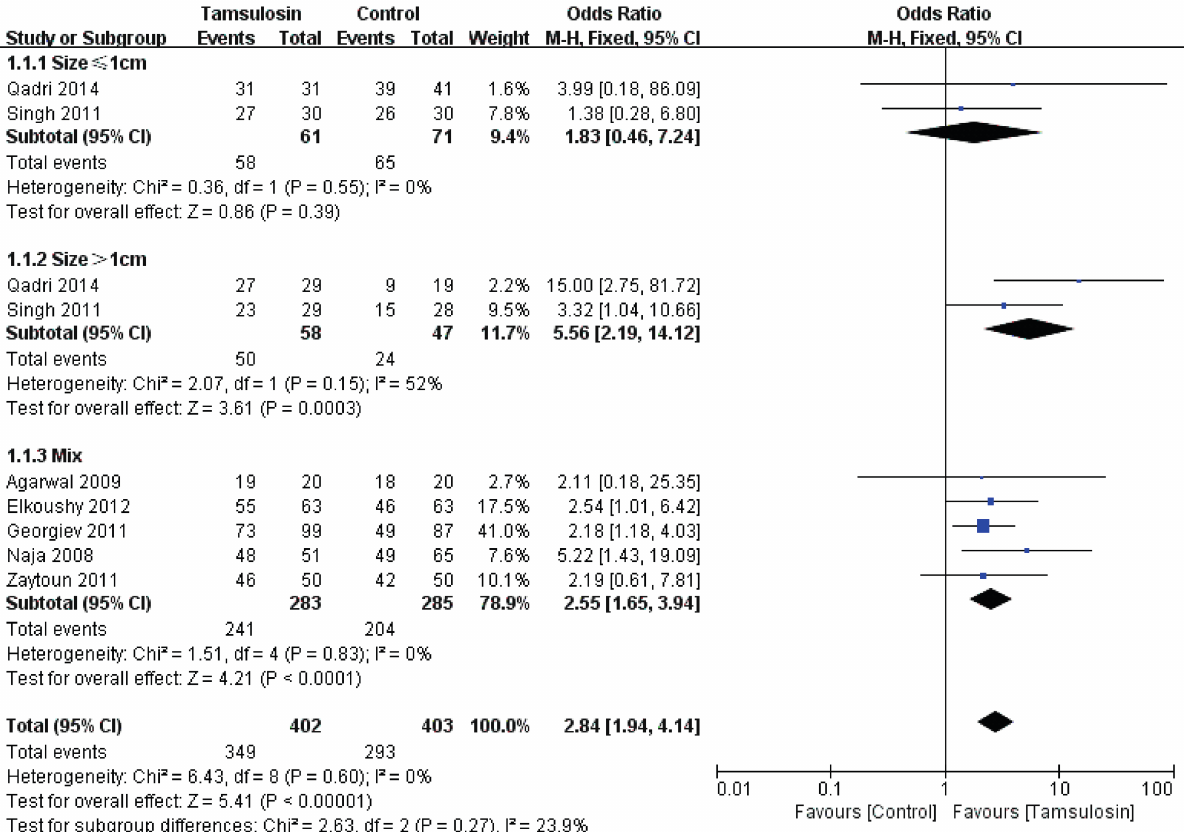
Figure 1 - Forest plots with stone clearance as the outcome according to the